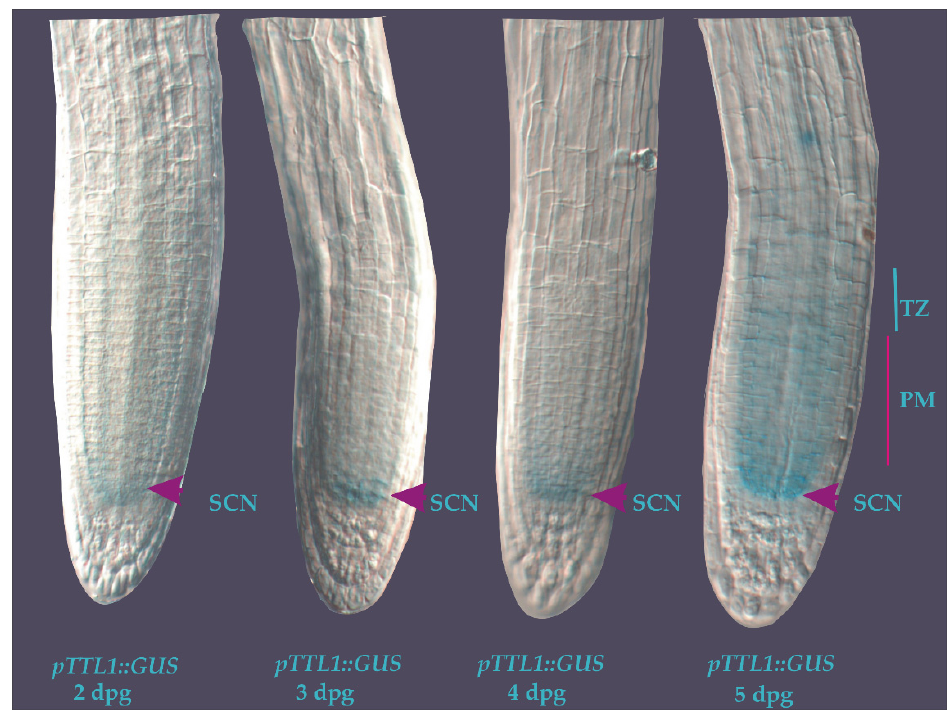
Figure 5. Expression patterns of TTL1 in Arabidopsis primary root using promoter::GUS analysis from 2 to 5 days post germination in control medium. pTTL1::GUS roots showing GUS signal in the stem cell niche (SCN) from 2 to 4 dpg (arrowheads). At 5 dpg the signal is also localized in the cortex, endodermis, and stela cells in the PM and transition zone (TZ). n = 15.